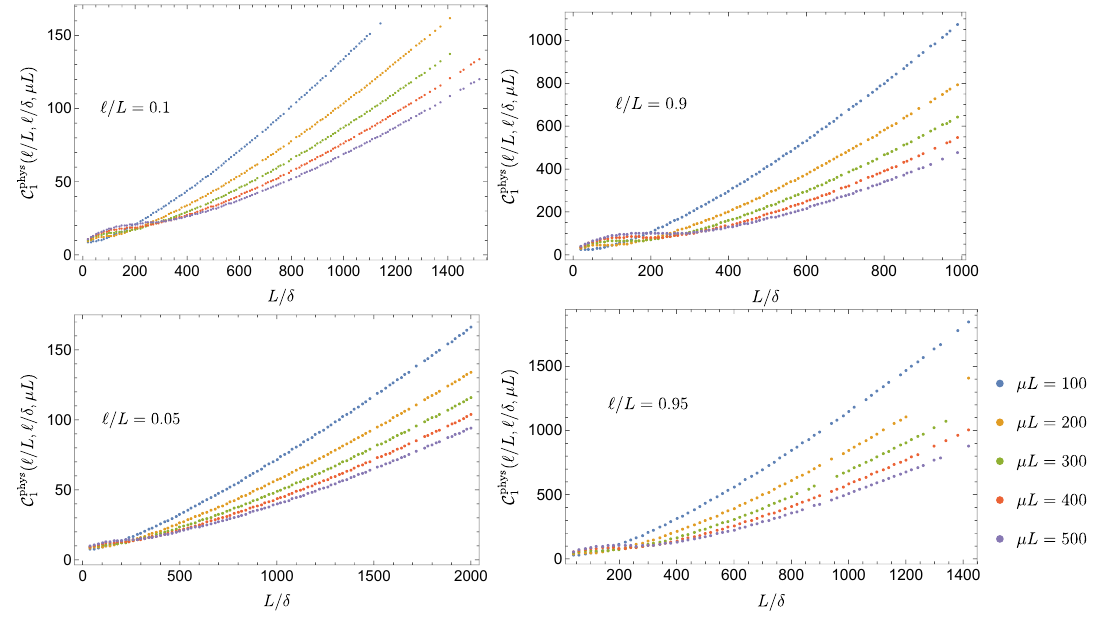
Figure 20 . Subregion complexity in the physical basis as a function of the cuto(cid:11) N = L=(cid:14)